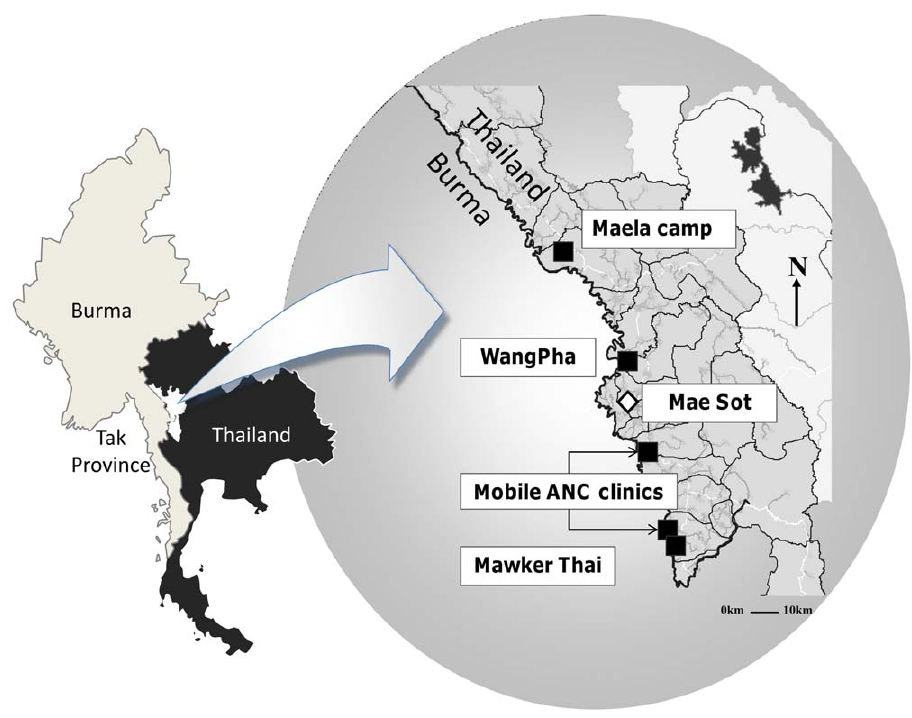
Figure 1. Geographical setting of the antenatal clinics of the Shoklo Malaria Research Unit. Location of the Shoklo Malaria Research Unit antenatal clinics and Mae Sot, the main town in the Thai province of Tak, bordering Burma. The locations of the antenatal clinics are represented by squares.